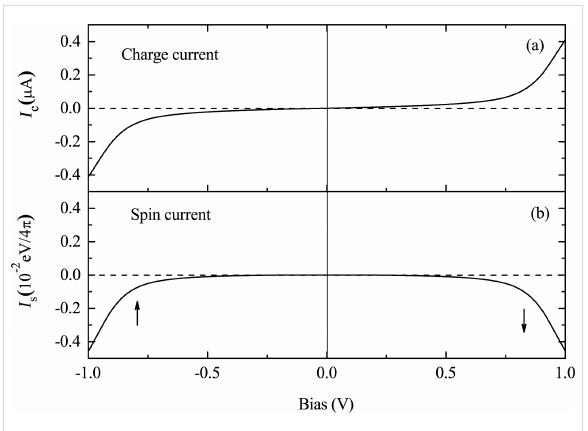
Figure 8: Bias-dependent (a) CC and (b) SC through an asymmetric OF device with N = 20 and E F = 0. The arrows in (b) indicate the SP of the current. Reproduced with permission from [33], copyright 2008 AIP